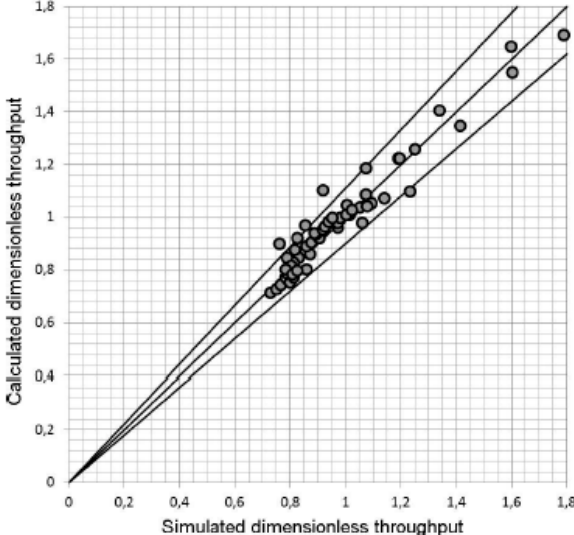
Figure 6. Polynomial regression of data—reprinted with permission from [23].